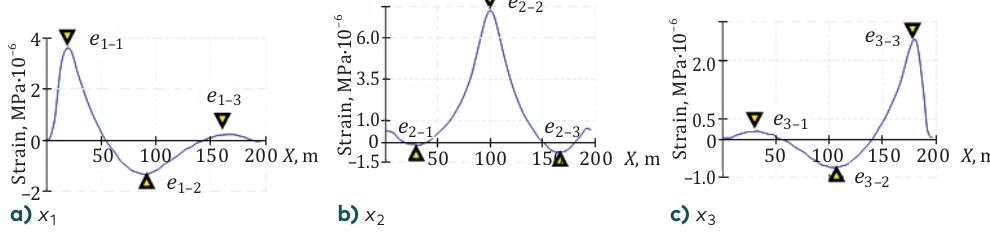
Figure 19. Dynamic strain responses collected by the long-gauge Fiber Bragg Grating sensors